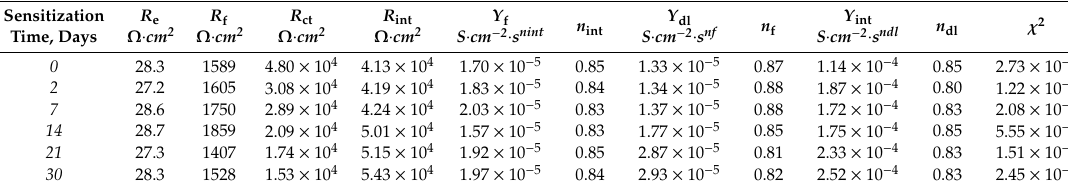
Figure 12. Physical model and electrical equivalent circuit (EEC) diagram of the proposed system of AA5083 in 3.5 wt% NaCl solution. Table 3. EIS fitting results using the EEC shown in Figure 12.